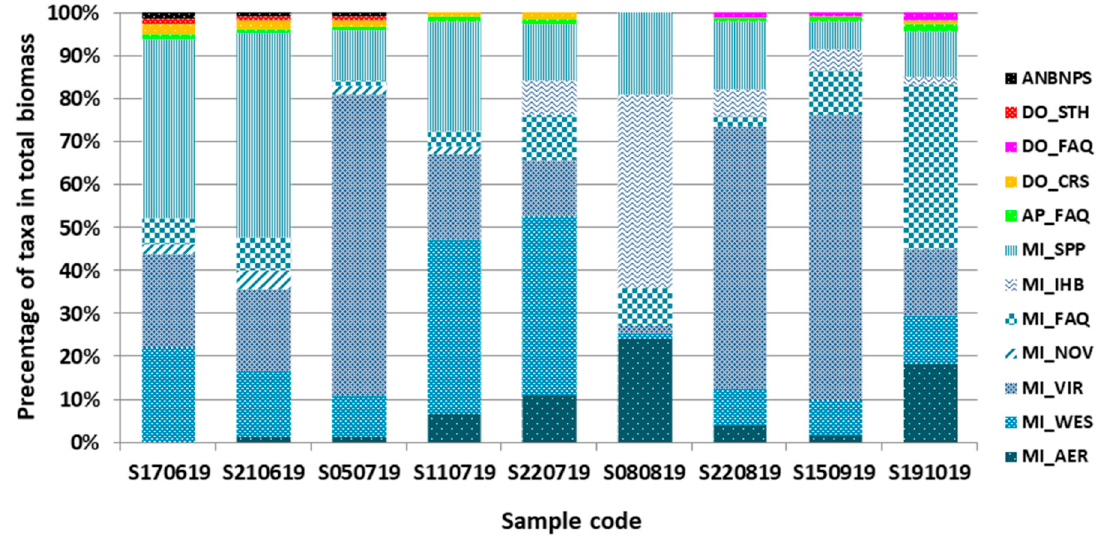
Figure 7. Qualitative and quantitative structure of cyanobacterial bloom in the samples from Stryk ó w artificial reservoir based on the percentage share of taxa in the total biomass; sample code consist